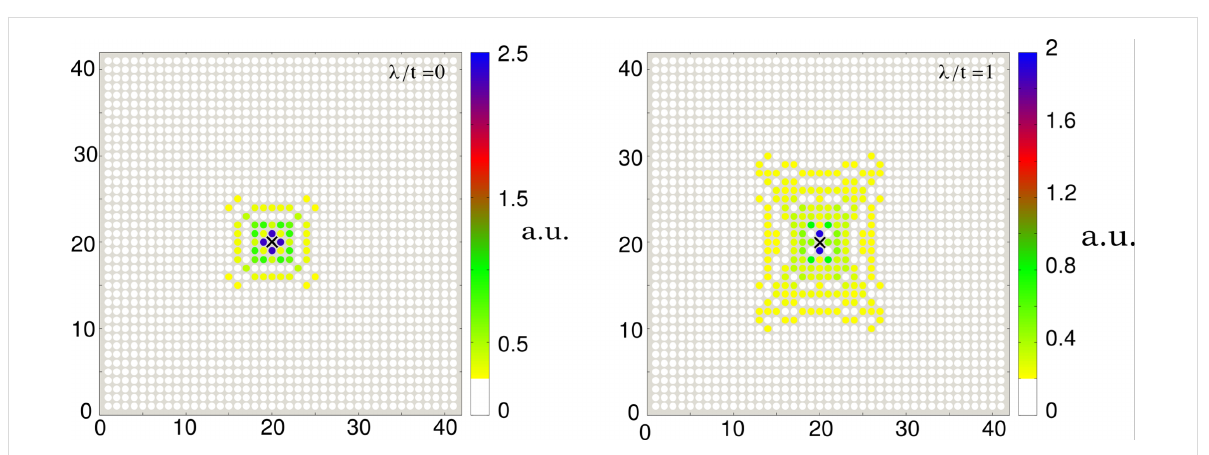
Figure 2: Spatial profiles of the YSR states obtained for | J | < J c in the absence of spin–orbit coupling (left panel) and for strong in-plane cou- pling λ = t (right panel). The spin–orbit field is chosen along the x -axis and leads to an additional imaginary hopping term along the y -axis, which elon- gates the YSR states in the y -direction. The impurity spin is oriented along the (0, 0, 1) direction.